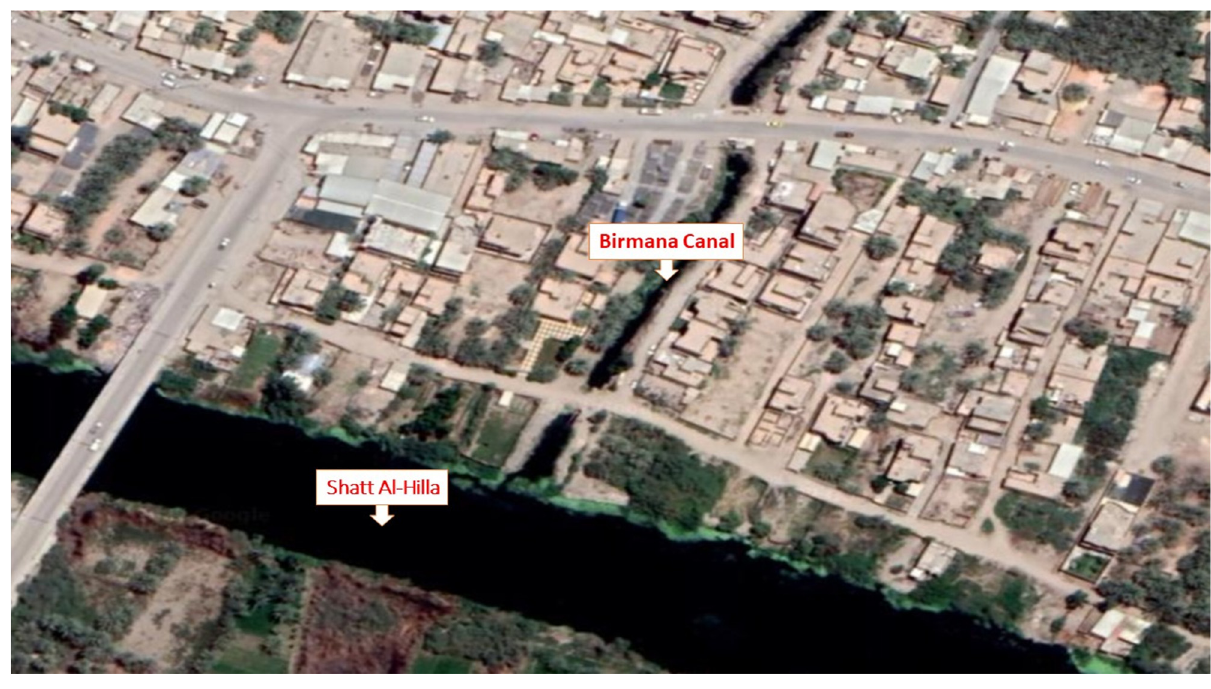
Figure 2: Birmana unlined canal.